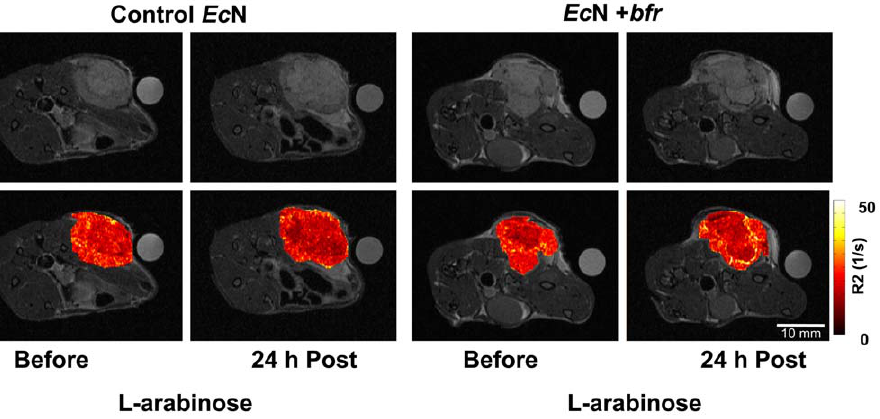
Figure 4. R2 relaxation maps of tumors obtained before and after induction of protein expression. Tumor-bearing mice were injected with control bacteria (left) or P BAD - bfr encoding EcN (right). Upper panels: Before, and 24 h after injection of L-arabinose, mice were imaged in a 7T small animal scanner (TE/TR 30/4000 ms:). Lower panels: In addition, images at TE: 10, 20, 40, and 80 ms (TR: 4000 ms) were obtained and used to generate R2 relaxation maps of tumors, which were overlayed on top of the images shown in the upper panels.